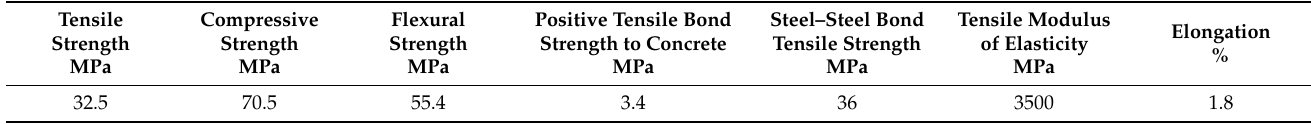
Table 2. Safety performance index of adhesive for sticking steel plate.